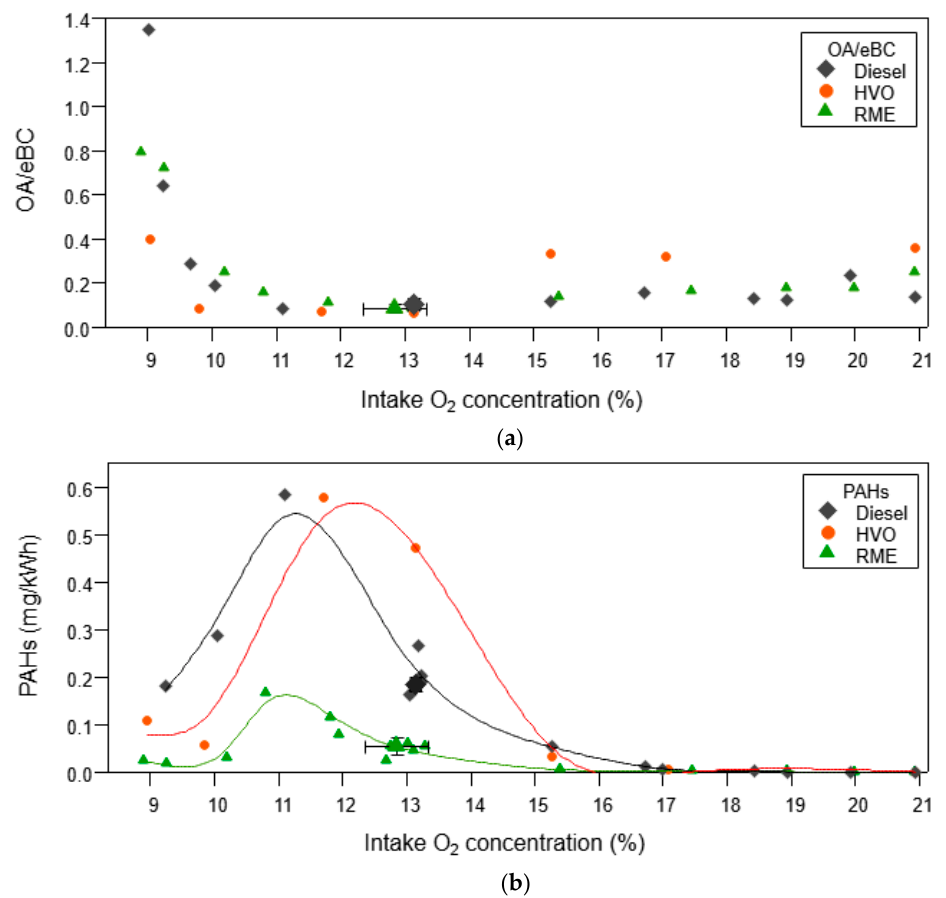
Figure 2. ( a ) The organic aerosol to equivalent black carbon ratio (OA/eBC) and ( b ) polycyclic aromatic hydrocarbons (PAHs) emission factors (mg/kWh) vs. exhaust gas recirculation (EGR) expressed as intake O 2 concentration. The lines shown in ( b ) are interpolated values and are only included to guide the eye. PAH and OA concentrations were assessed from the aerosol mass spectrometer (AMS) data. The OA fraction increase for all fuels as the O 2 concentration decrease at high levels of EGR (i.e., O 2 < 11%). The RME fuel strongly decreases the PAH emissions compared to HVO and diesel, independently of EGR. The data in Figure 2 are from single EGR sweeps with relatively short averaging time in each point (~1.5 min), except at 13% intake O 2 where repeated measurements for diesel and RME was performed (displayed with error bars of ±1 std. dev.). The calculated variability in terms of relative standard deviations of the replicates was ±25% (OA/eBC) and ± 10–36% (PAHs) of the mean values. The variability may have been slightly larger for the EGR sweeps due to the shorter averaging time.